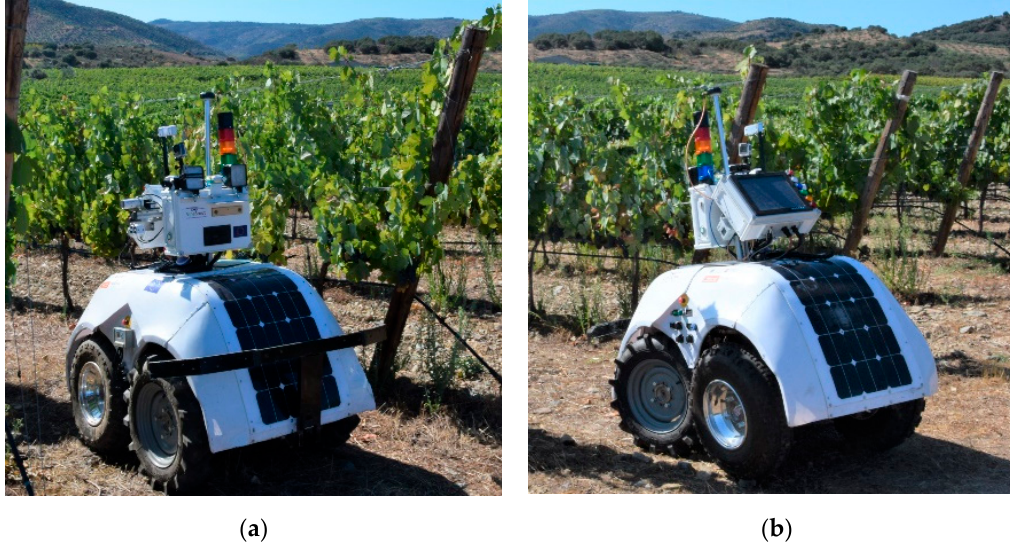
Figure 2. Version II (2019) of VineScout autonomous robot: Front ( a ) and rear ( b ).